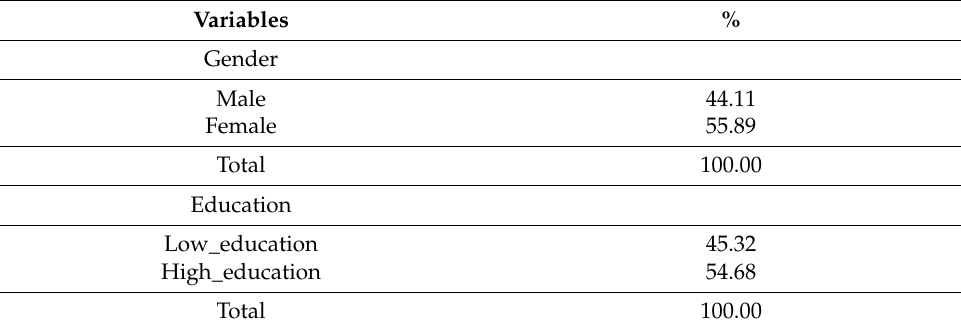
Table 1. Socio-demographic characteristics of the sample ( n =